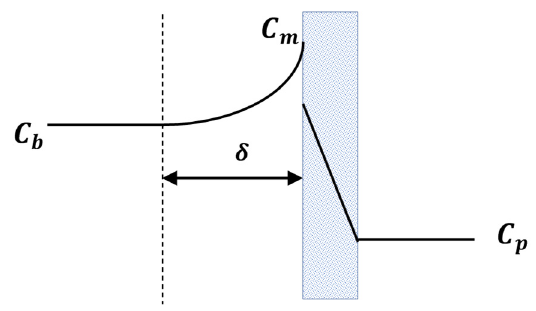
Figure 1. Schematic of concentration polarization phenomena in ultrafiltration. Between the bulk feed solution (the region of constant C b ) and the membrane there is the mass transfer boundary layer feed solution (the region of constant 𝐶 𝑏 ) and the membrane there is the mass transfer boundary of thickness δ . Within this region the concentration is said to be layer of thickness 𝛿 . Within this region the concentration is said to be polarized.